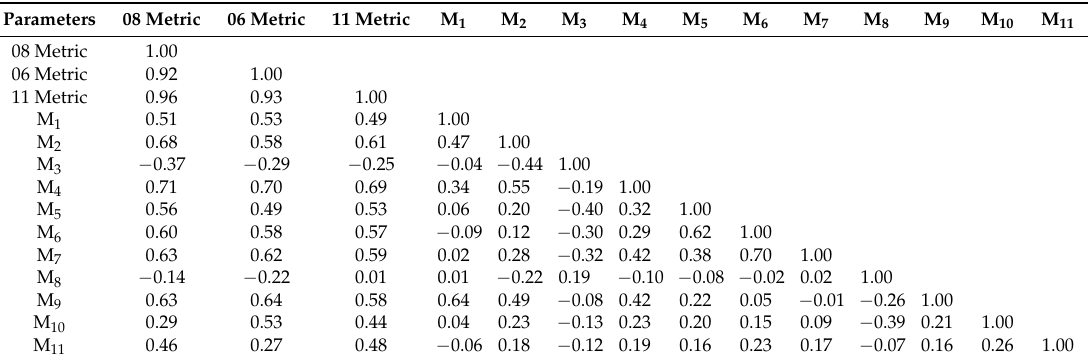
Table 8. Correlation matrix between the three mmIBI models and individual metrics applied during the